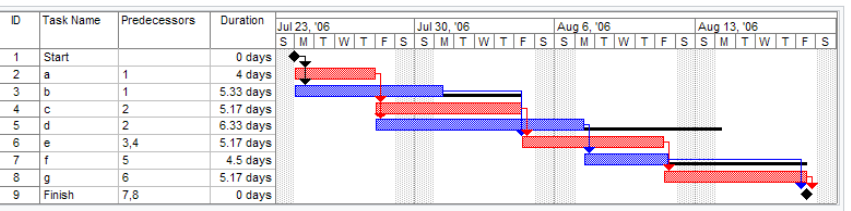
Fig. 8. Example of Gantt Chart